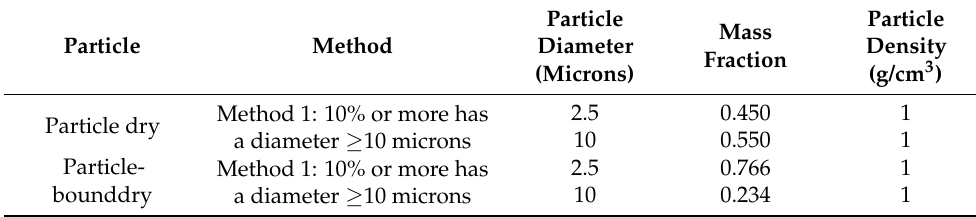
Table 3. Particle size distribution